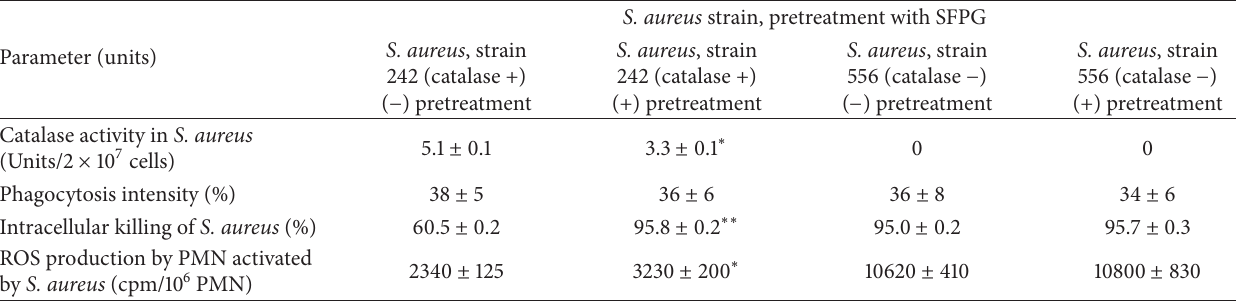
Table3:Effectsof S.aureus pretreatment(+)withstandardisedfermentedpapayagelontheircatalaseactivity,ROSproduction,phagocytosis, and intracellular killing by human granulocytes.